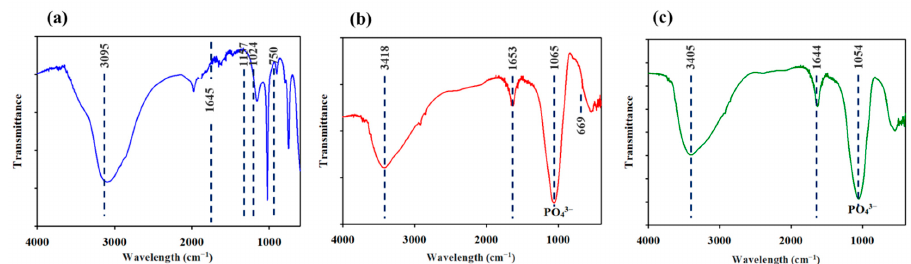
Figure 6. FTIR spectra from different materials; ( a ) pure lepidocrocite, P-Fe precipitates after using L-Fe dissolved solution with ( b ) HCl and ( c ) H 2 SO 4 .